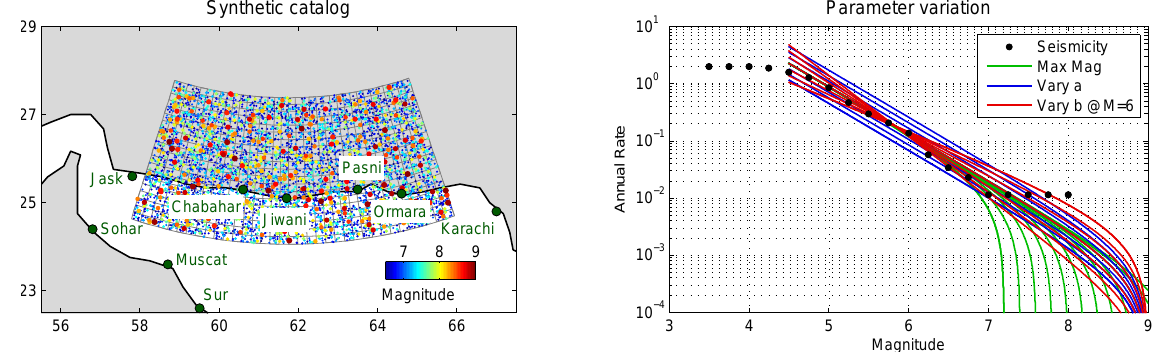
Figure 2. Left: first 5000 events in the reference synthetic catalog color-coded by magnitude (larger on top). The whole catalog spanning 300000 years contains about 20000 events. Right: parameter range tested for the magnitude–frequency